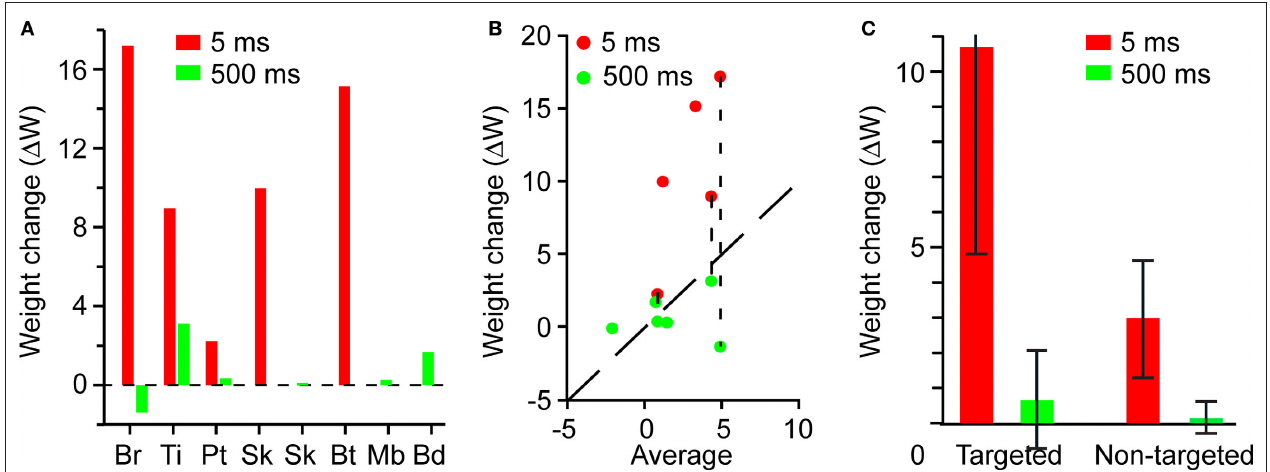
for all non-targeted connections; equal values lie on the diagonal dashed line. Paired results for experiments with two stimulation electrodes are identified by vertical dashed lines. (C) Average connectivity changes ∆ W for targeted and non-targeted connections, at 5- and 500-ms latency. The upper error bound for the targeted, 5-ms connections has been